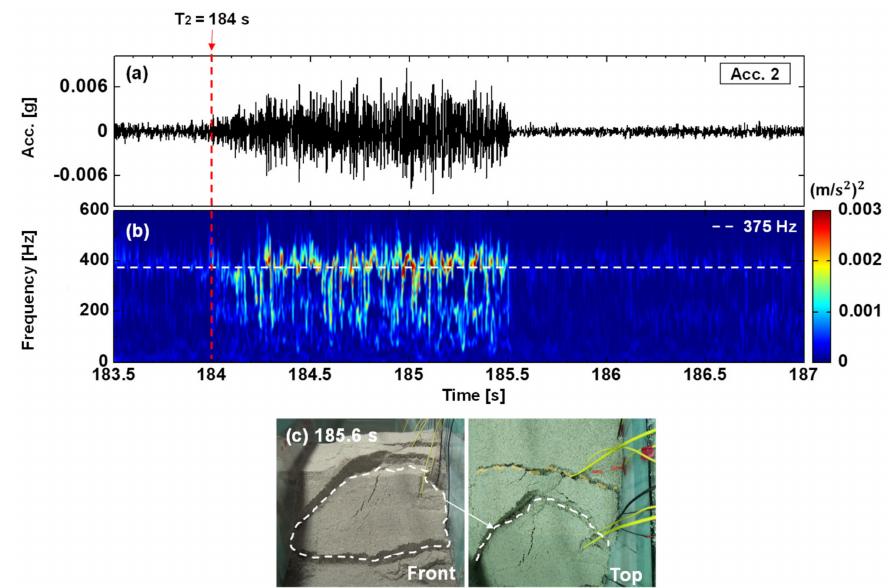
Figure 8. Event 3, the single slide: ( a ) seismic signal, ( b ) time–frequency spectrum, ( c ) front and top view of the single slide.